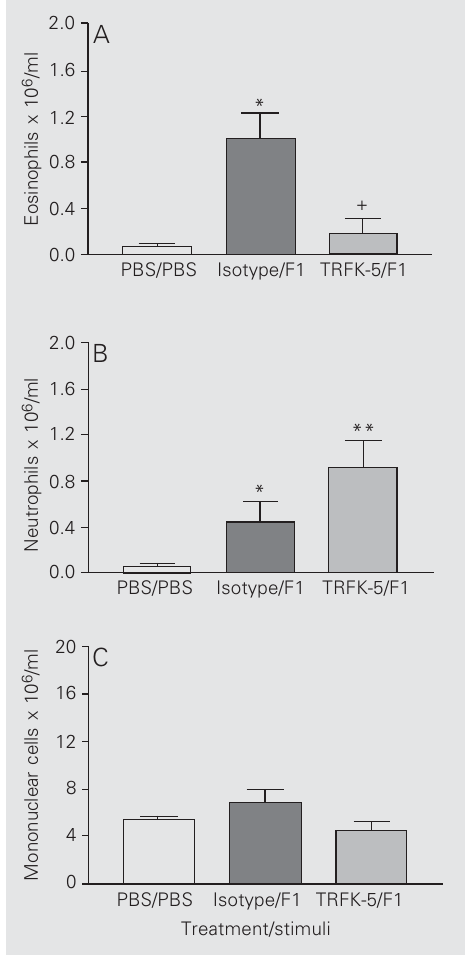
Figure 1. Effect of pretreatment with TRFK-5 on mononuclear cell, neutrophil, and eosinophil recruitment. C57BL/6 mice re- ceived 300 µg polysaccharide fraction 1 (F1) isolated from the cell wall of Histoplasma capsu- latum , ip . Cell numbers are re- ported as the mean ± SEM for 5-7 mice per group. *P < 0.01 and **P < 0.001 vs PBS/PBS group; + P < 0.01 vs isotype/F1 group (two-way